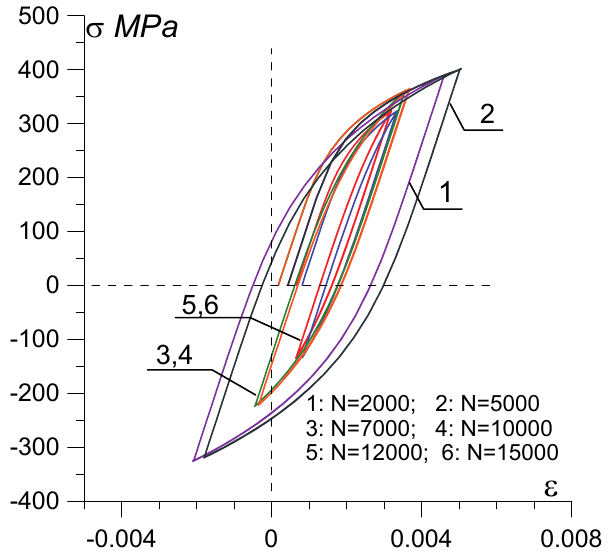
Figure 10: Stress-strain loops at the decreasing mean load value calculated with the use of Garud-Mroz